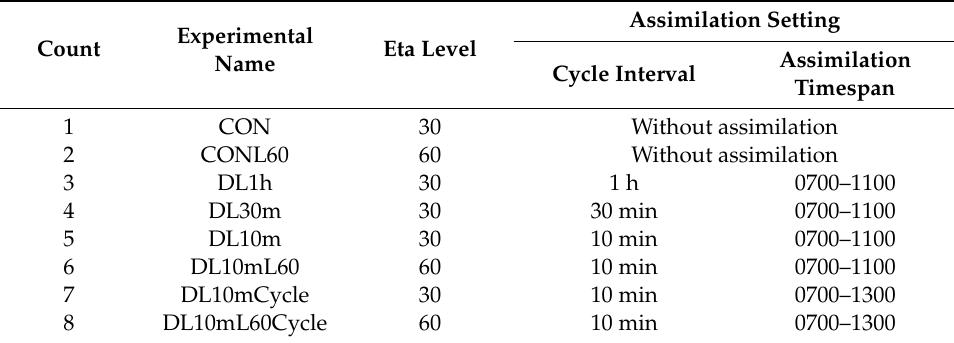
Table 1. Details of experimental designs. Count